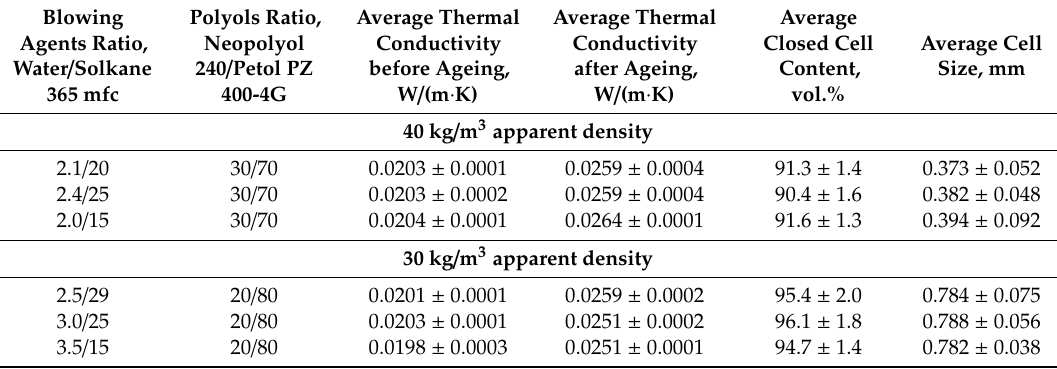
Table 6. Average values of thermal conductivities and structural parameters of polyurethane foam. Blowing Agents